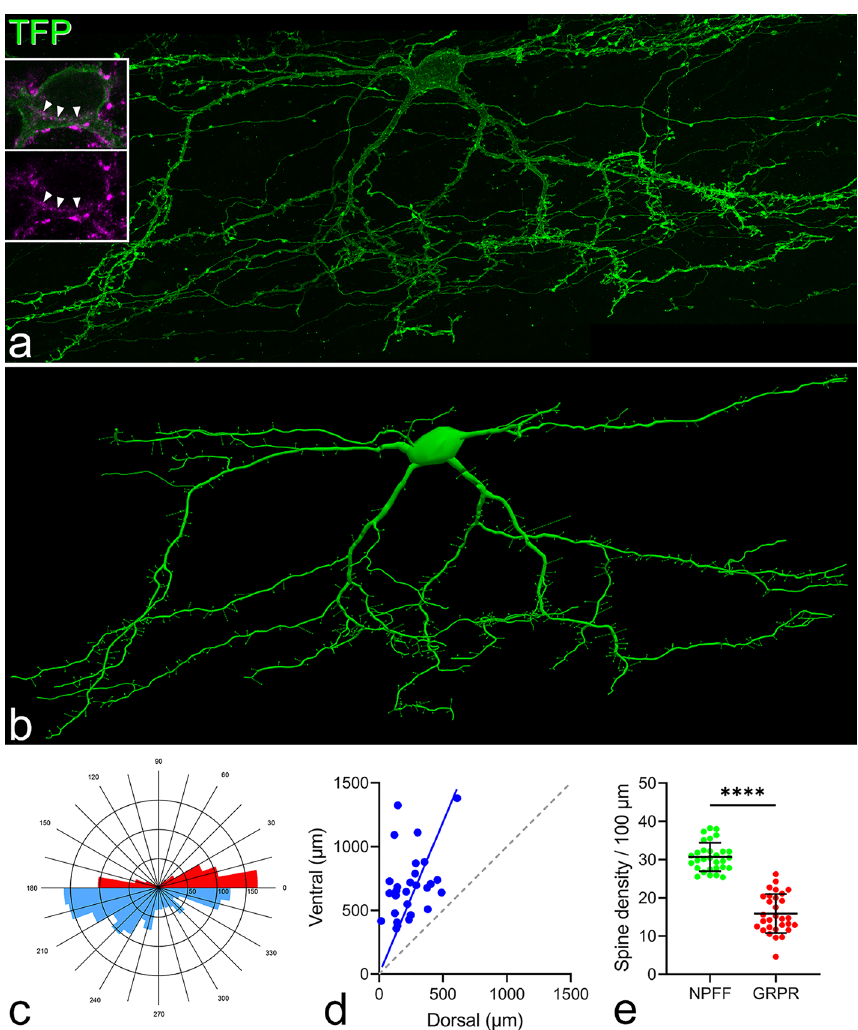
Figure 8. Dendritic morphology of NPFF cells revealed with the viral Brainbow technique. ( a ): a maximum intensity projection (99 optical sections at 0.5 μm z-separation) showing part of a sagittal section from a NPFF Cre mouse that had received intraspinal injections of Brainbow AAVs. The section has been scanned to reveal TFP (green), and examination of confocal images showed that this was the only labelled cell within this field. Insets show labelling for TFP (green) and immunostaining for pro-NPFF (magenta) in a more restricted projection (4 optical sections). The cell body contains pro-NPFF immunoreactivity, which occupies part of the perikaryal cytoplasm, and this is marked by arrowheads. There are also pro-NPFF-immunoreactive profiles outside the cell body, and these are likely to be pro-NPFF-containing axons that may be forming synapses on the Brainbow- labelled cell. ( b ): a Neurolucida reconstruction of the cell shown in ( a ). Positions of dendritic spines are shown, although the sizes of the spine heads and shapes of spine necks in this drawing do not represent the actual sizes and shapes of these structures. Note the high density of dendritic spines on this cell. ( c ): a polar histogram for this cell. Dorsally directed dendrites are shown in red and ventrally directed dendrites in blue. ( d ): A plot of the ratio of the lengths of ventrally-directed (ventral) to the lengths of dorsally-directed (dorsal) dendrites obtained from polar histograms for the 30 NPFF cells analysed in this study. The blue line shows the mean ratio for these cells, while the black dashed line corresponds to a ratio of 1. ( e ): Comparison of the dendritic spine density between the 30 NPFF cells labelled with the Brainbow technique and 30 GRPR cells labelled with the same method from Polgár et al 18 . Scale bar ( a , b ) = 50